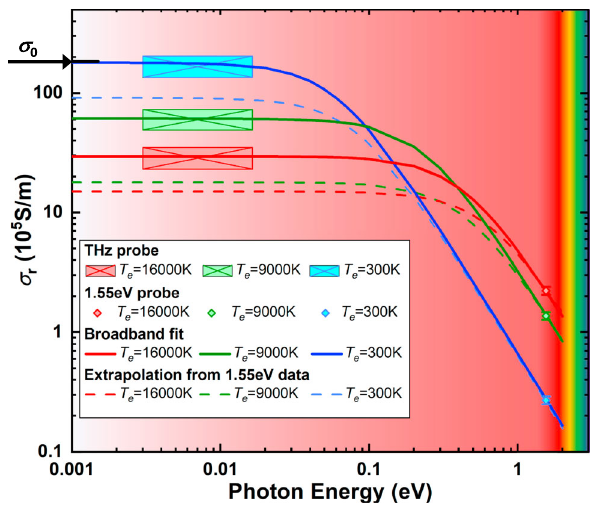
Fig. 4 Time-resolved electrical conductivity σ 0 of gold (logarithmic vertical axis) at mean excitation energy density of 0.89 ± 0.18 MJ/kg measured by multi-cycle THz-FEL at various time delays. Each section covers a time interval of 5 ps and the data present an averaged over 4 – 6 shots. The error-bars include the standard deviation and the systematic error of the measurements. The data after 0 ps are fi t by a two-segment exponential decay function represented by the dashed and the dotted lines. The intersection of these two curves at t = 14.5 ps coincides with the melting phase transition of